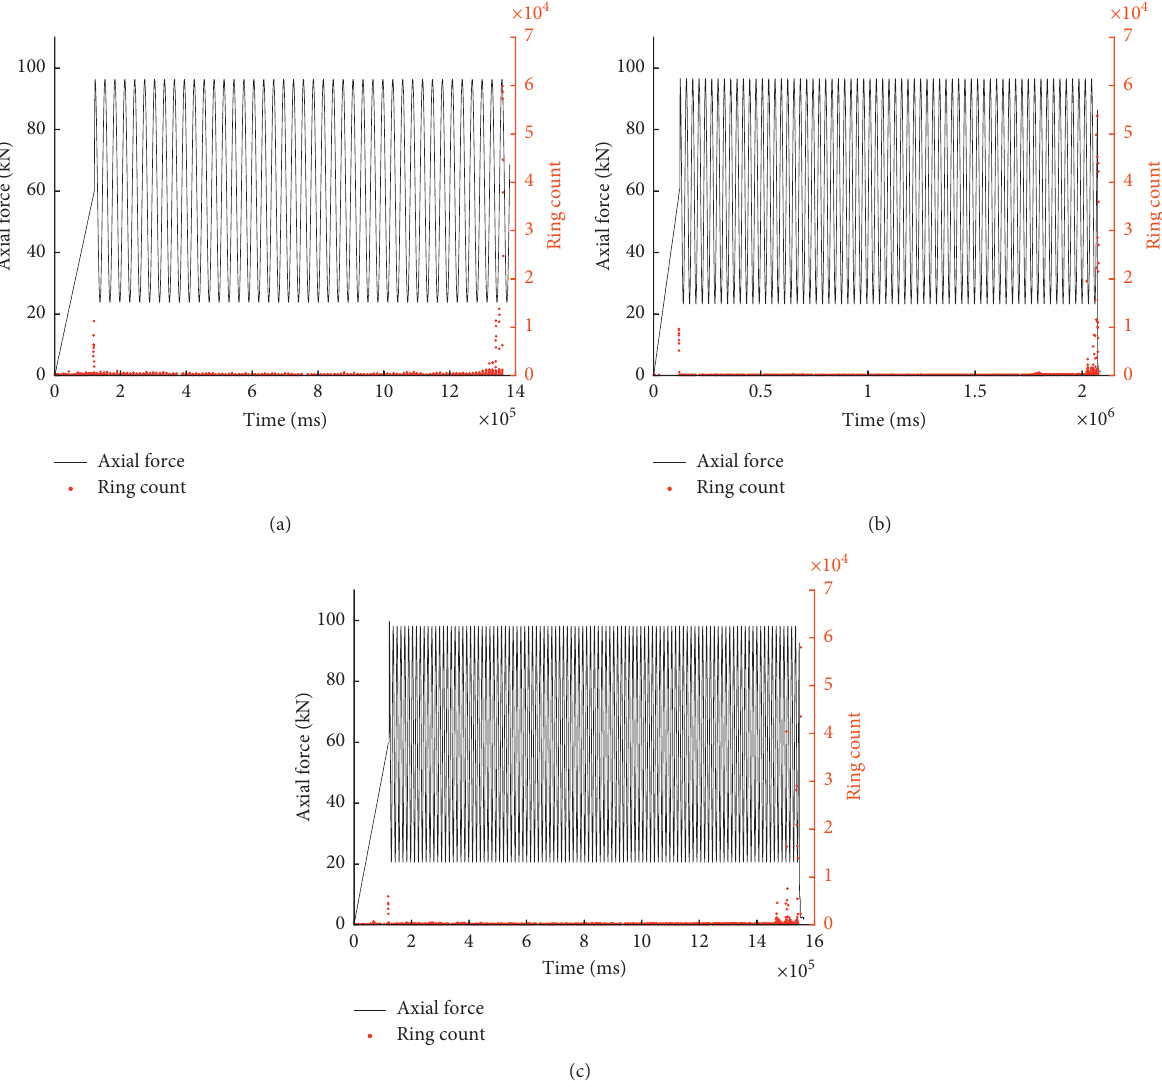
Figure 5: Acoustic emission evolution of sandstone under different loading frequencies. (a) Evolution of acoustic emission at 0.1 Hz frequency. (b) Evolution of acoustic emission at 0.2 Hz frequency. (c) Evolution of acoustic emission at 0.5Hz